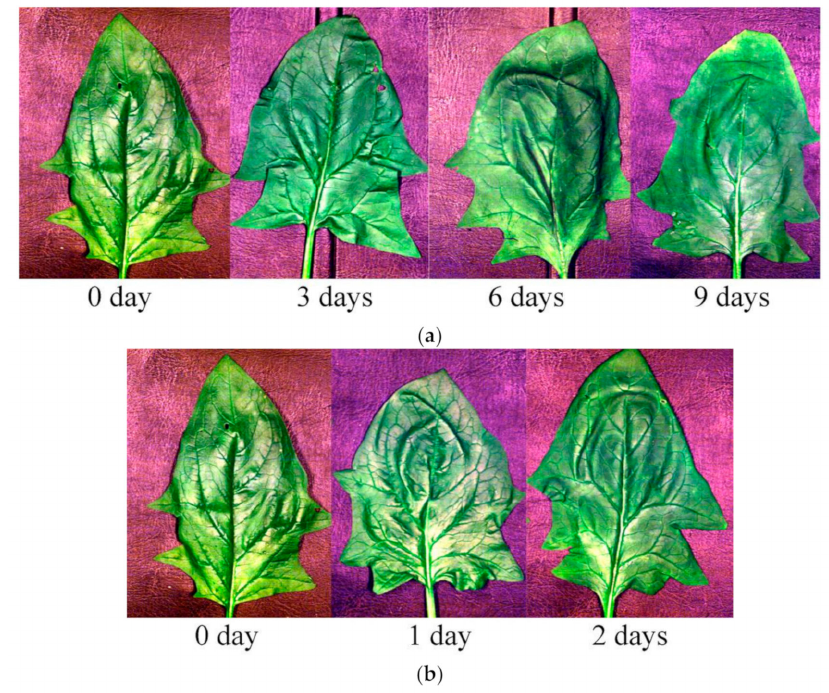
Figure 1. RGB images of spinach leaves preserved under di ff erent temperature conditions: ( a ) 4 ◦ C; ( b ) 20 ◦